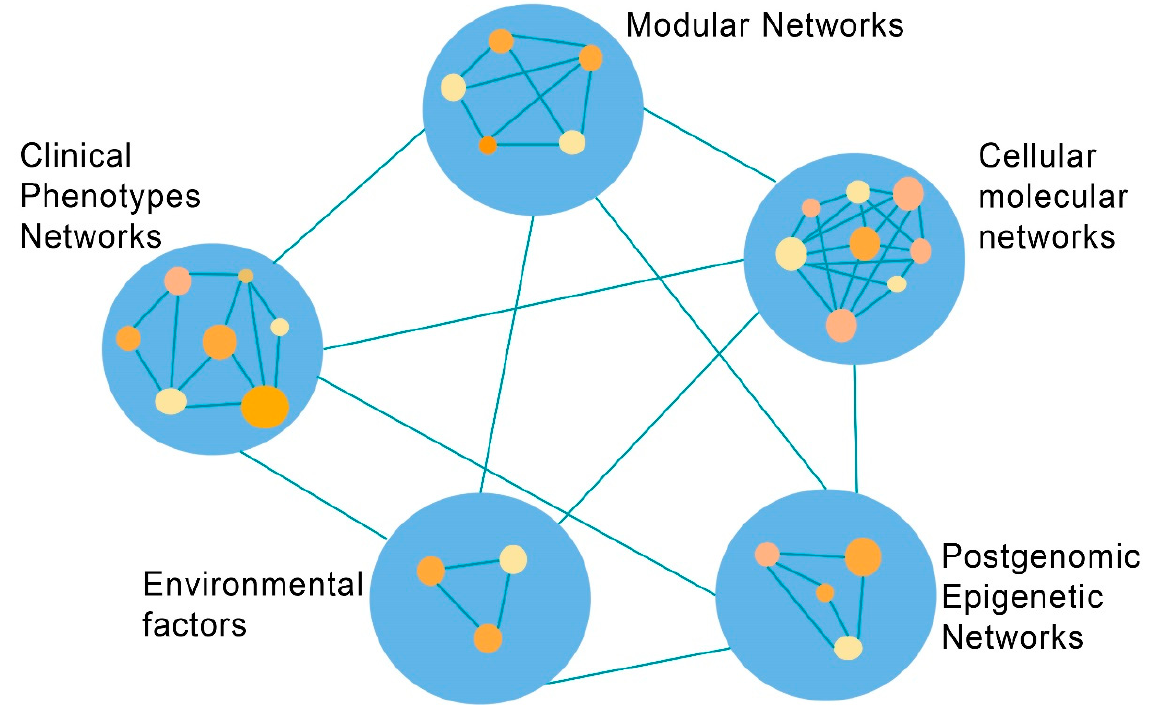
Figure 2. Coronary artery disease: The network complexity between systems biology discipline levels and environmental factors. (Revised from: [11]).